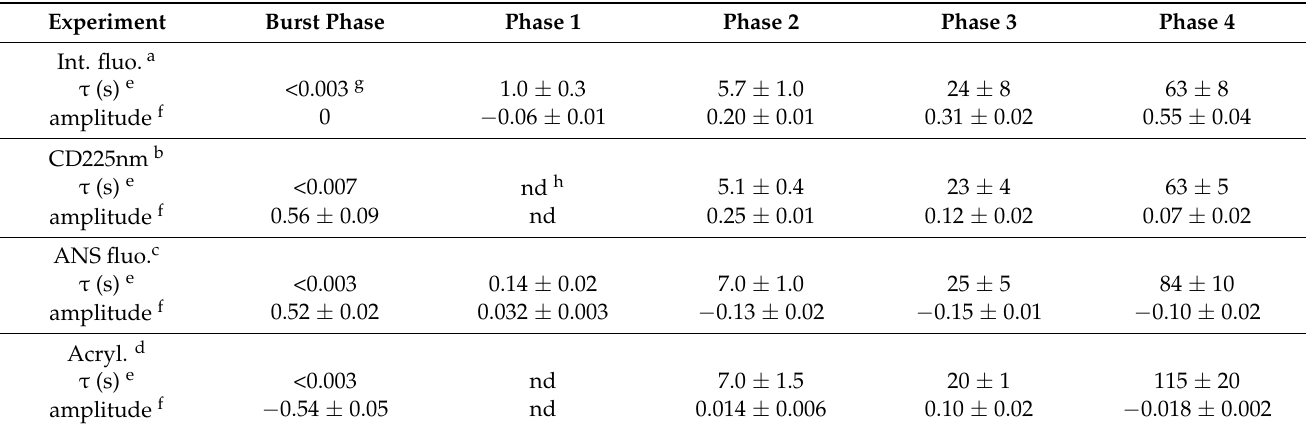
Table 1. Kinetic parameters for the refolding of PemA after rapid mixing in 0.4 M GdmCl at pH 7, 25 ◦ C.